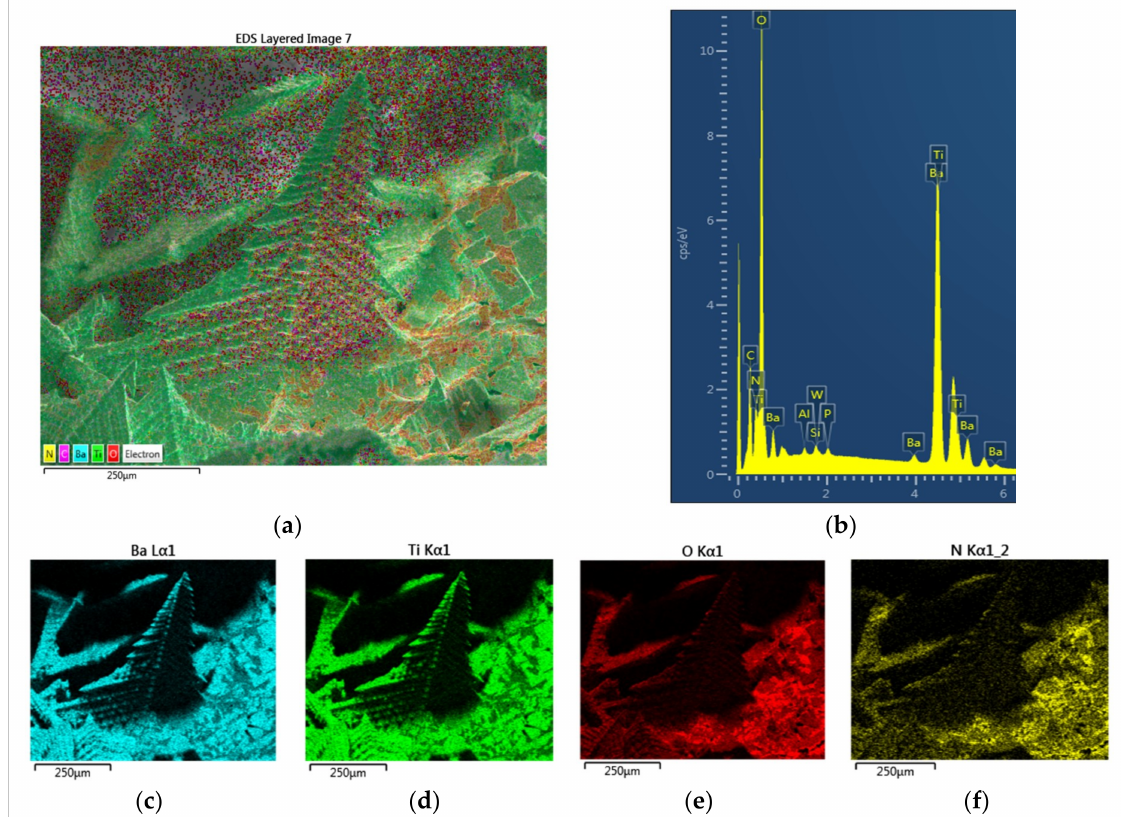
Figure 11. The e ff ect of 10 min microwave irradiation at 1800 W in air with plasma generation inside the BaTiO 3 particle (Particle-4 in Figure 8). ( a ) EDS layered image of an electrical tree; ( b ) EDX-spectra of the area in ( a ) with composition: [O] = 0.678; [N] = 0.070; [Ba] = 0.136; [Ti] = 0.116; ( c ) Ba-mapping; ( d ) Ti-mapping; ( e ) O-mapping ( f )